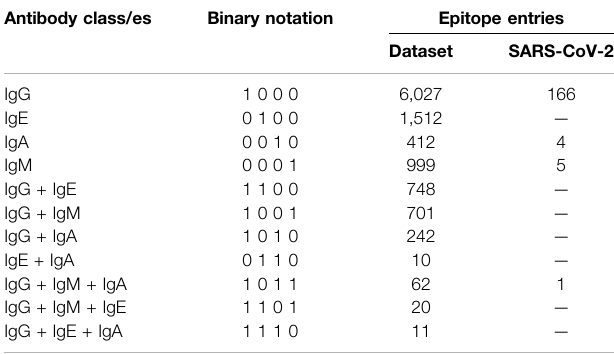
TABLE 1 | Composition of datasets used in the